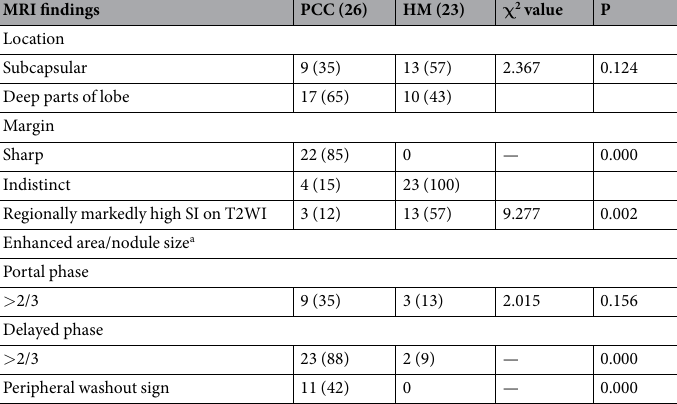
Table 1. MRI findings of peripheral cholangiocarcinoma and metastatic hepatic hypovascular nodules. Note: a, Estimate at the maximum cross-sectional area. Data are presented as the number of patients with percentage in parentheses. Percentages are calculated on the basis of each group. PCC, peripheral cholangiocarcinoma. HM, hepatic metastases. SI, signal intensity.